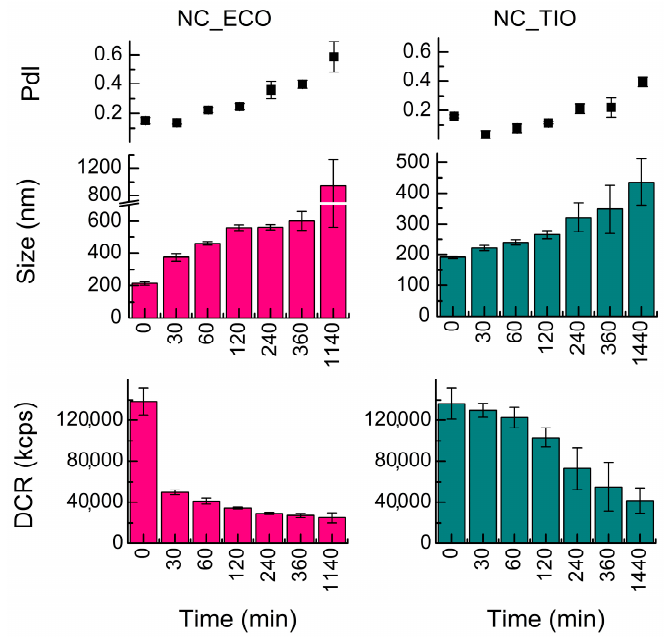
Figure 3. Evolution of the size (Z-average diameter), polydispersity index (PdI), and derived count rate (DCR) with time of drug-loaded nanocapsules (NC) incubated at 37 °C in simulated vaginal fluid (SVF) and acetate buffer. Data shown are means ± SD ( n = 3).